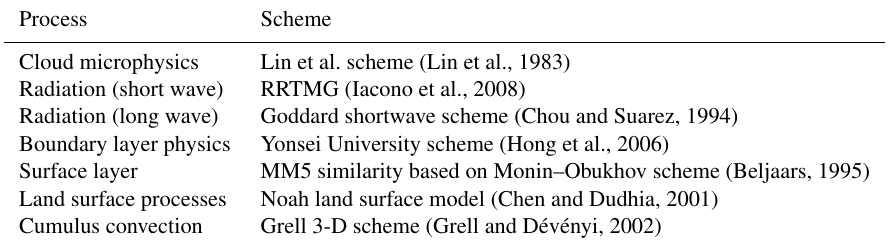
Figure 1. Source regions and receptors: (a) division of domain into nine source regions. Note that the Rest_Eu source region also includes ship emissions from the Atlantic, Mediterranean, and Baltic Sea, whilst emissions from shipping routes in the North Sea and the English Channel are tagged as NOS. The blue line surrounding the domain indicates the lateral-boundaries (LB) tag. (b) Map of the UK showing the receptor regions. Table 1. Parameterizations options used in the